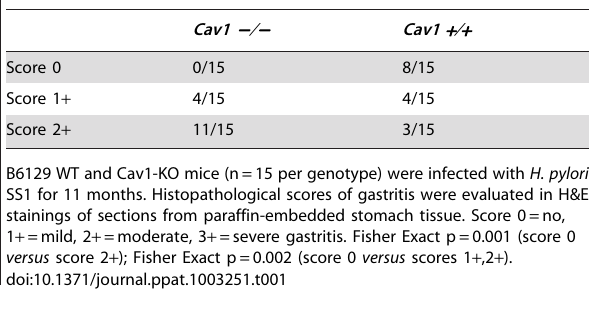
ylated focal adhesion kinase (FAK) in Cav1-expressing cells infected with H. pylori G27. These data corroborated that AGS/ Cav1 cells infected with CagA-delivery competent H. pylori maintained their spread-out epithelial shape as compared with the stressed elongated phenotype of Cav1/EV cells.